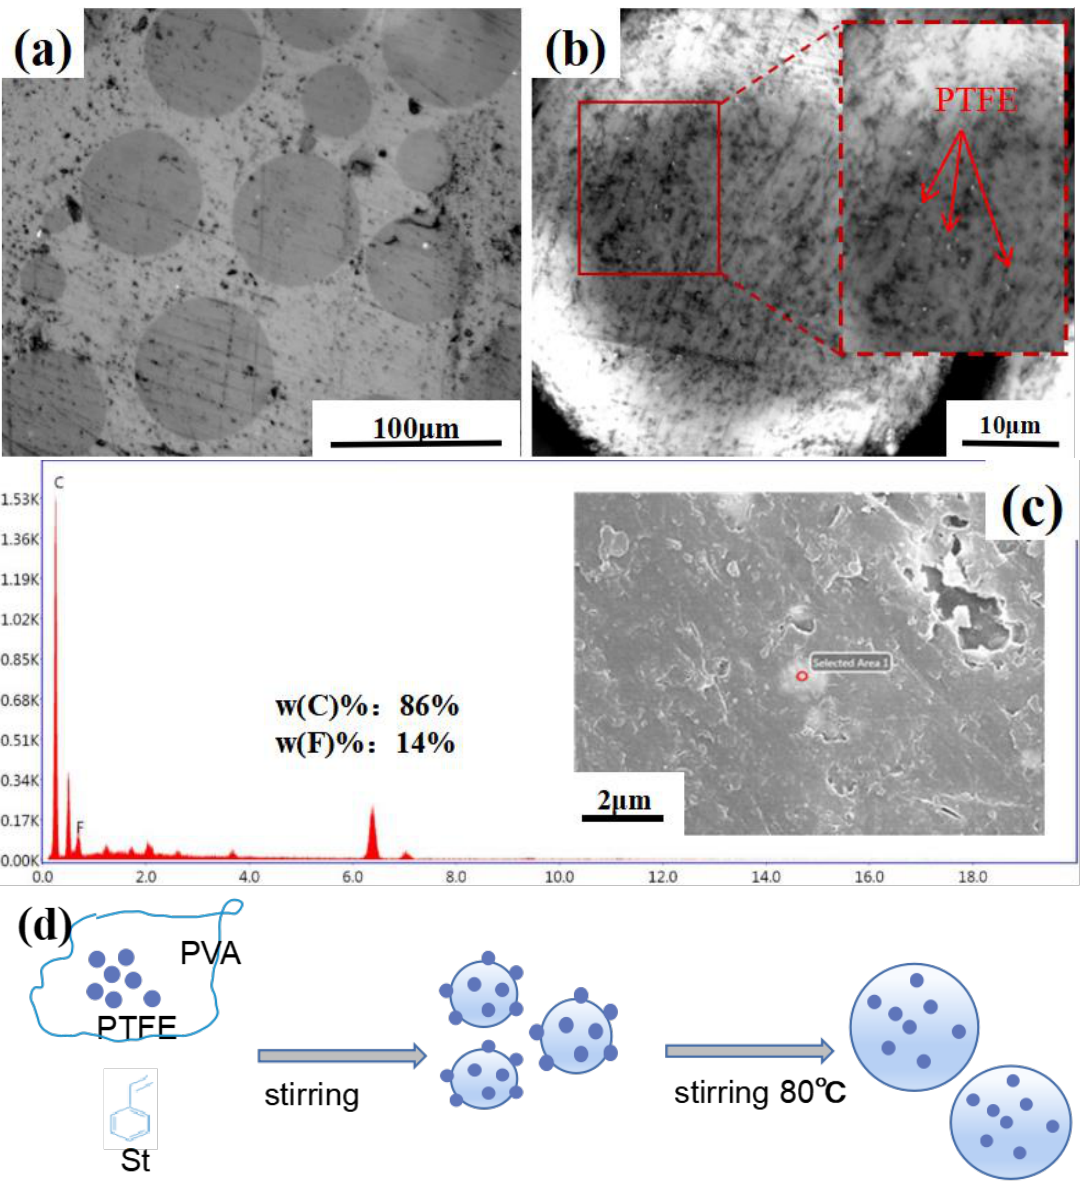
Figure 5. ( a ) Metallograph of PTFE/PS before acetone corrosion, ( b ) metallograph of PTFE/PS after acetone corrosion, ( c ) EDS analysis of small particles in PTFE/PS, ( d ) schematic of PTFE/PS.